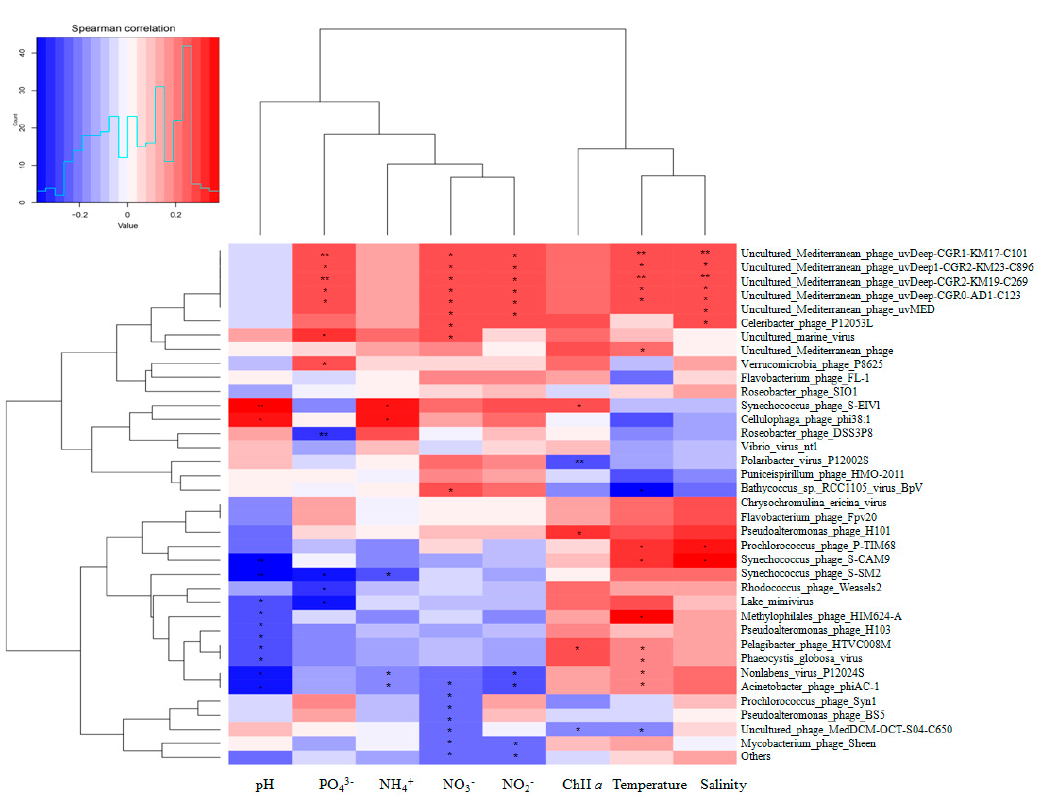
Figure 4. Correlation analysis between relative abundances of main viral species and environmental parameters based on Pearson correlations. The r-values indicate the correlation values of Pearson correlations. The P values indicate the statistical significance levels (single* p < 0.05 and double ** p < 0.01).